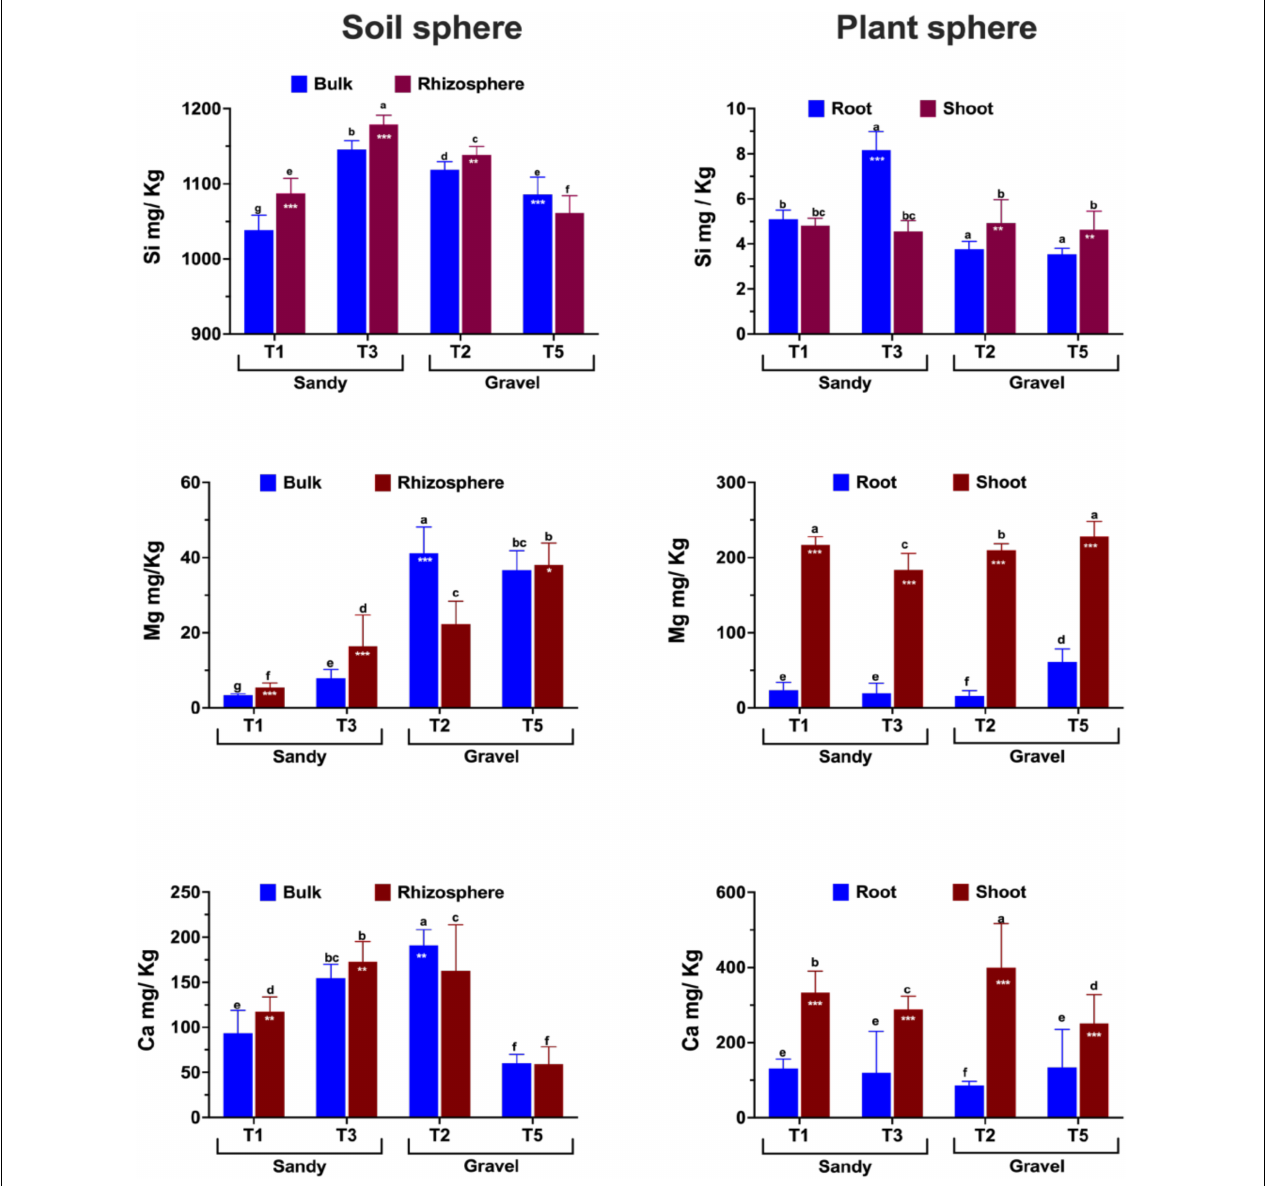
FIGURE 7 | Essential plant growth-related nutrient composition and abundance across soil (bulk and rhizosphere) and plant parts (shoots and roots) of different populations of Z. qatarensis . The error bars represent standard deviations. The different letter(s) on the graph indicate significant differences between treatments ( p < 0.05), as revealed by the DMRT test on SAS 9.0. The * p < 0.05, ** p < 0.001, and *** p < 0.0001 on selected bars indicate significant effects of drought